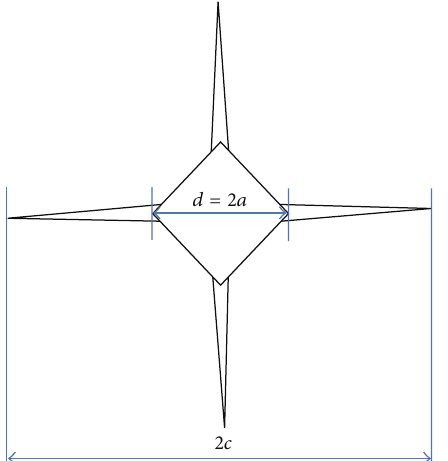
Figure 3: Crack created by the Vickers